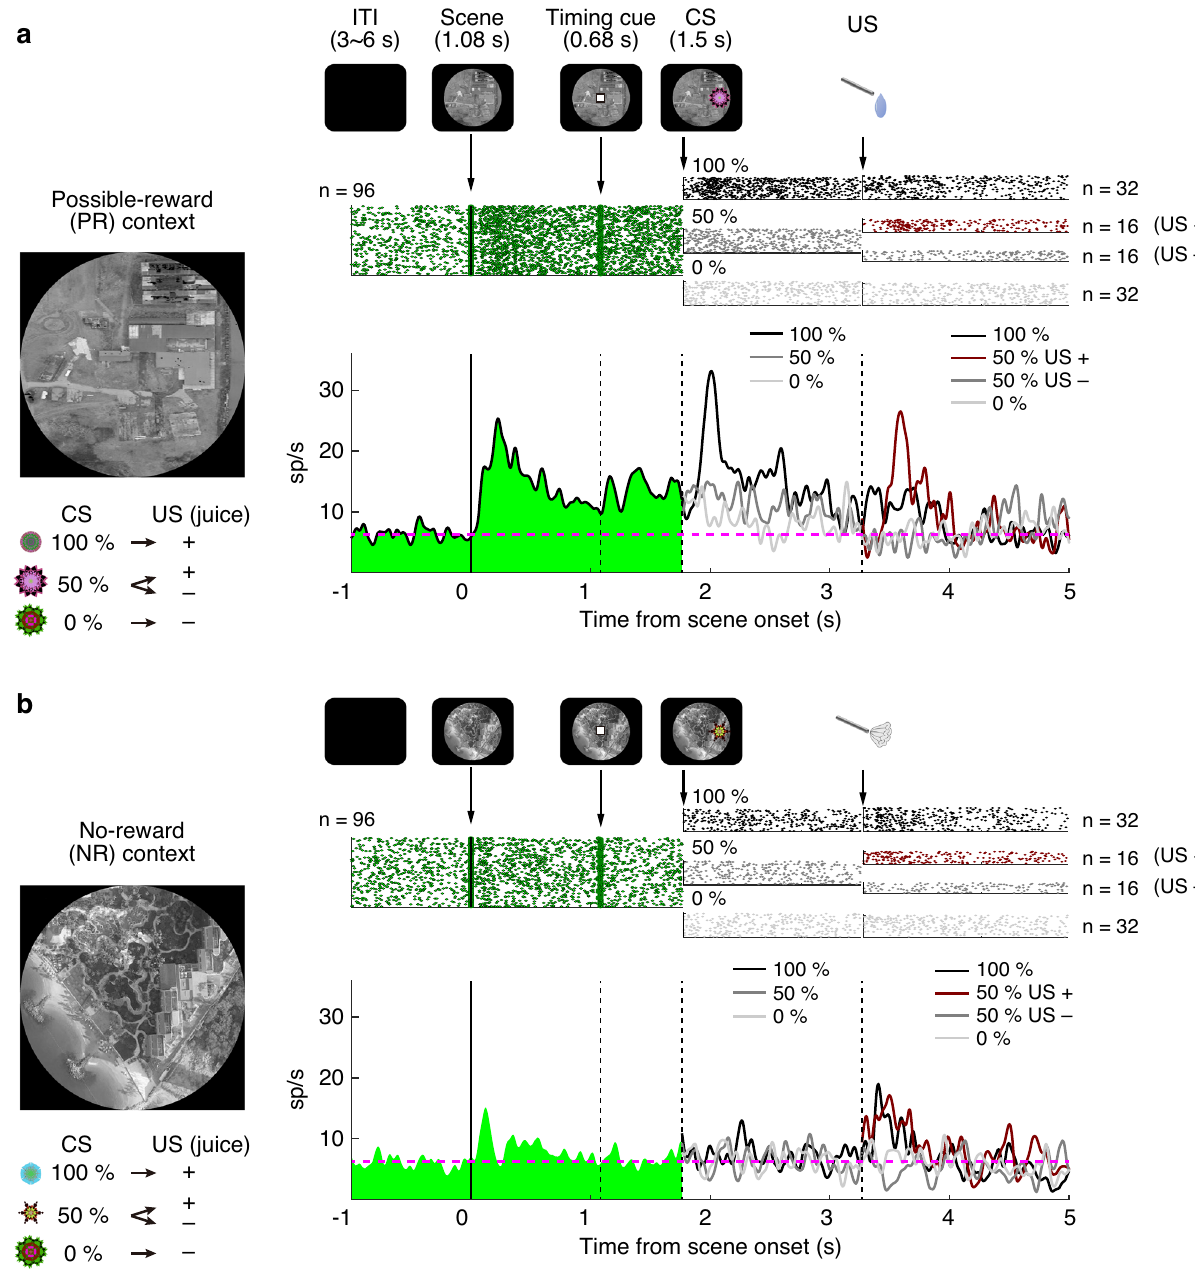
Fig.1|PutativeDAresponsetoenvironmentalcontexts.a Responsesofasingle putative DA neuron in the PR environment of Pavlovian task with scene. In the PR environment,aparticularscenewaspresented,andthreeconditionedstimuliwere associatedwithwaterwith100%,50%and0%probability,respectively. b Responses ofthesameputativeDAneuronintheNRenvironmentofPavloviantaskwithscene. In the NR environment, another scene was presented, and the other three condi- tioned stimuli were associated with air-puff with 100%, 50% and 0% probability, respectively. The environments were pseudo-randomly switched within the block. The trial started after the presentation of a scene image (diameter: 50 degrees) on the screen. After 1.08s, a timing cue was presented on the scene. After 0.68s, the